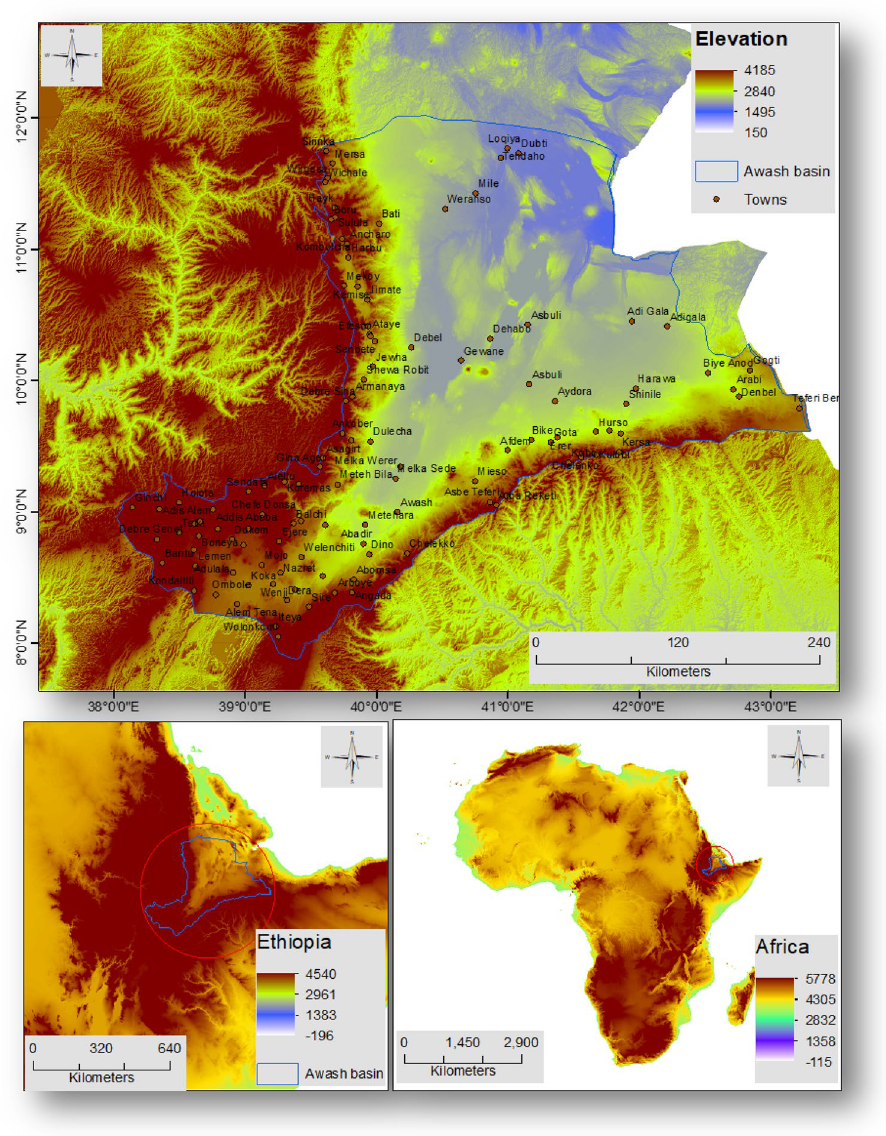
Figure 1. Location of the Awash basin, Ethiopia. This figure was created using ArcGIS 10.3.1